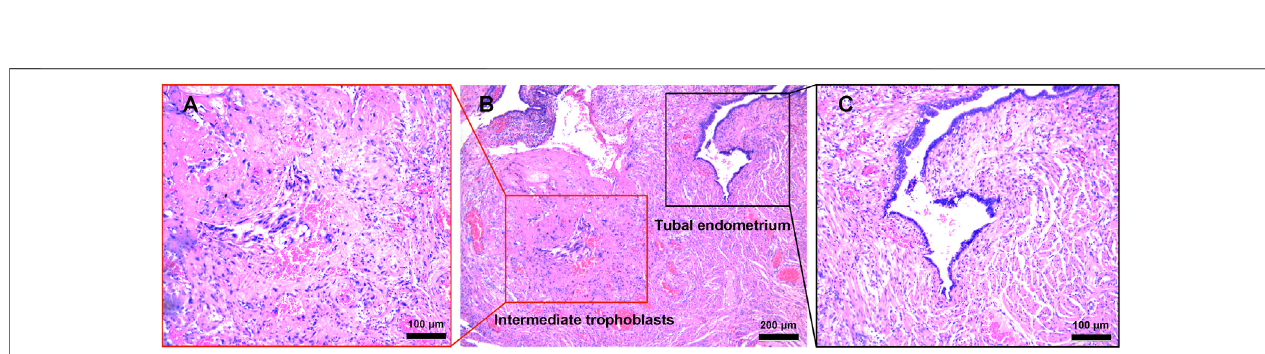
Frontiers in Physiology |